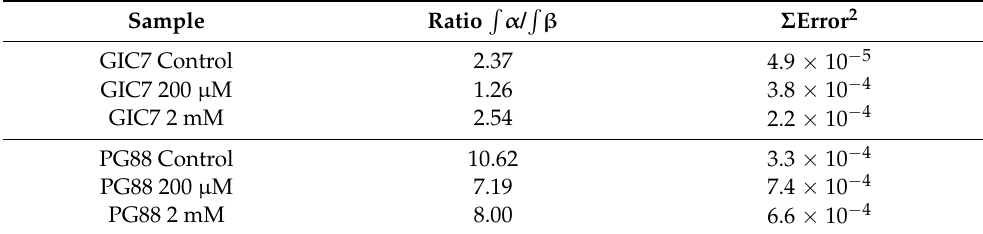
Table 1. Ratio of the α -helix and β -sheet Integrated spectra obtained from the deconvolution of Amide I from GICs. Sample Ratio